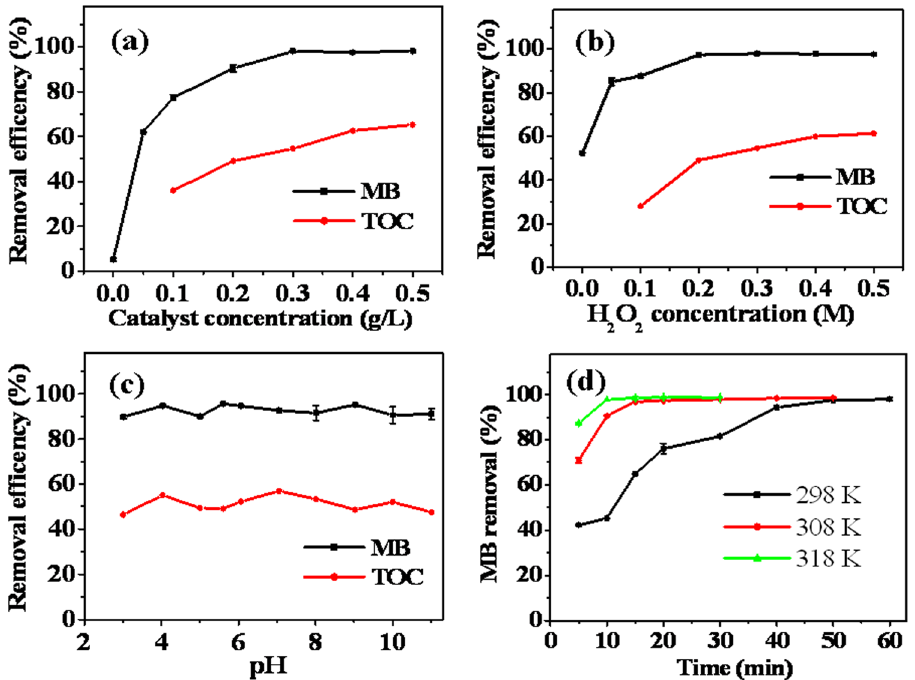
Figure 4. ( a ) Effect of catalyst concentration on the removal of MB and TOC (25 °C, pH 5.6, concentration of H 2 O 2: 0.2 M, concentration of initial MB: 20 mg/L). ( b ) Effect of H 2 O 2 concentration on the removal of MB and TOC (25 °C, pH 5.6, catalyst concentration: 0.2 g/L, concentration of initial MB: 20 mg/L). ( c ) Effect of solution pH on the removal of MB and TOC (25 °C, catalyst concentration: 0.2 g/L, concentration of H 2 O 2 : 0.2 M, concentration of initial MB: 20 mg/L). ( d ) Effect of reaction temperature on the removal of MB (pH 5.6, catalyst concentration: 0.2 g/L, concentration of H 2 O 2 : 0.2 M, concentration of initial MB: 20